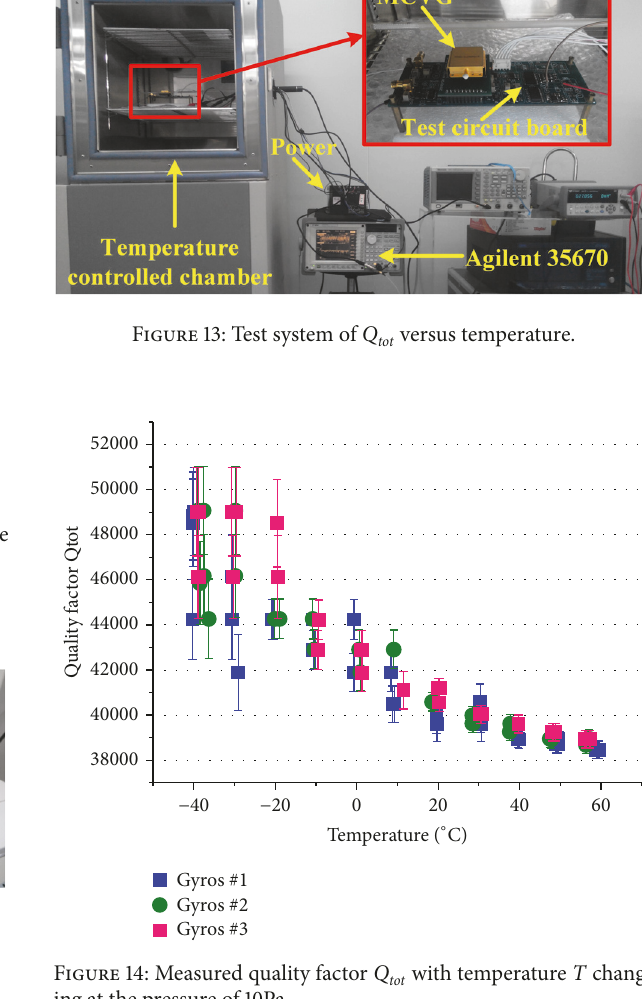
with temperature T chang- tot